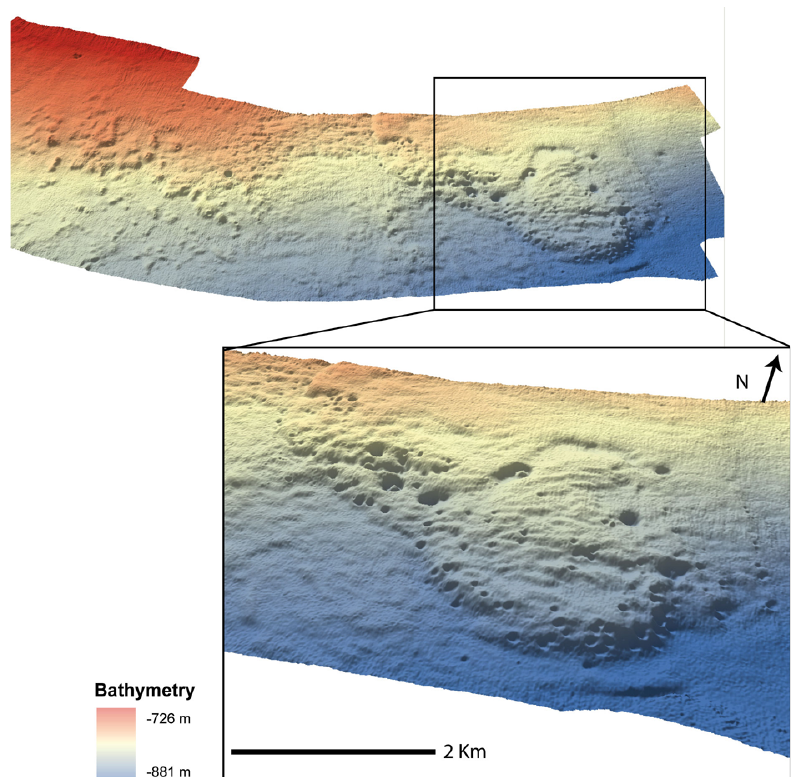
Fig. 3. Perspective view of the shaded relief DTM (resolution 5m and 10 × vertical exaggeration) of the study area showing the distribution of the pockmarks and their geometries; the inset shows a magnification of the highest density pockmarks area with more then 40 pockmarks with variable dimensions (8 of the major ones and up to 30 minor